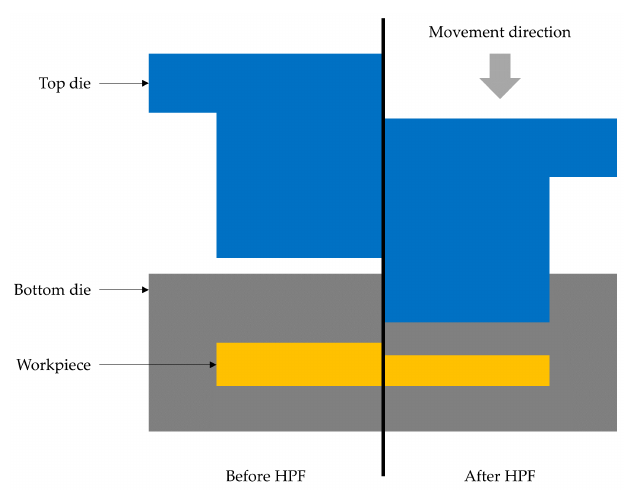
Figure 5. Top die approaching and leaving the workpiece, corresponding to the experimental work.